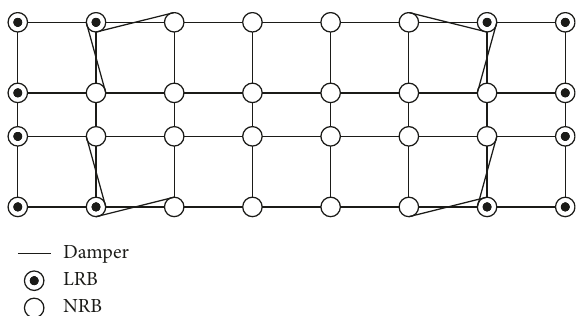
Figure 7: Distribution of isolators and dampers in the Los Angeles building describes the principal geometrical and mechanical 556 parameters of the rubber